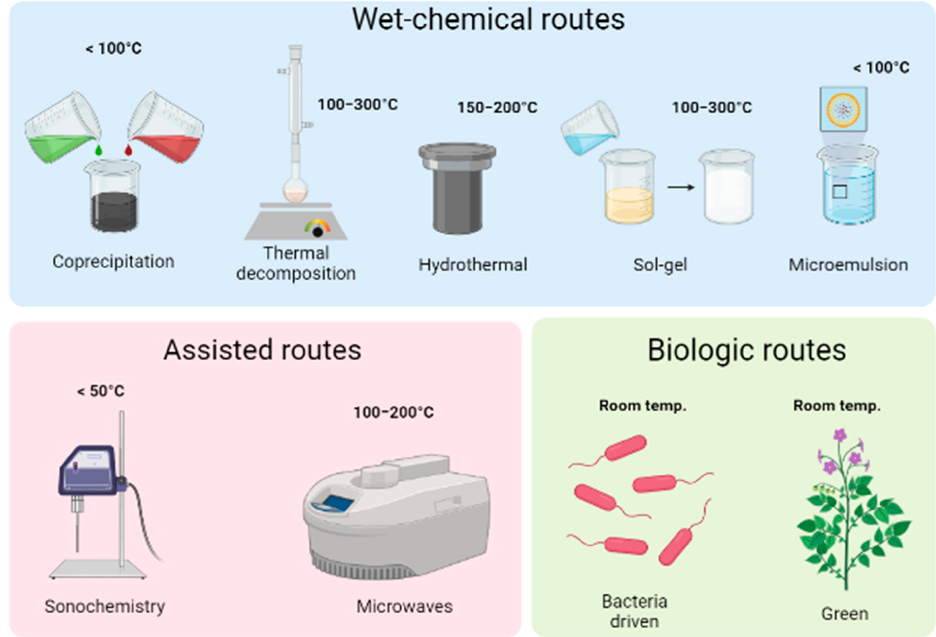
Figure 2. Graphical representation of the available synthesis routes used to produce MNPs.